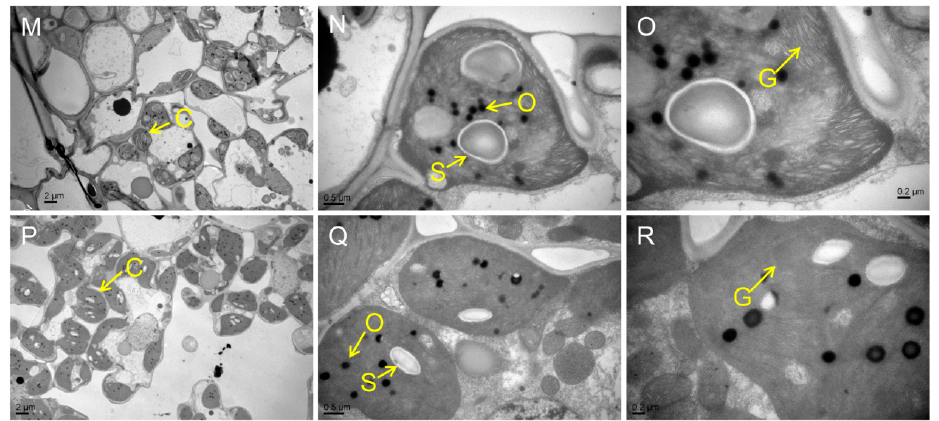
Table 2. Genetic analysis of premature senescence leaf mutants.